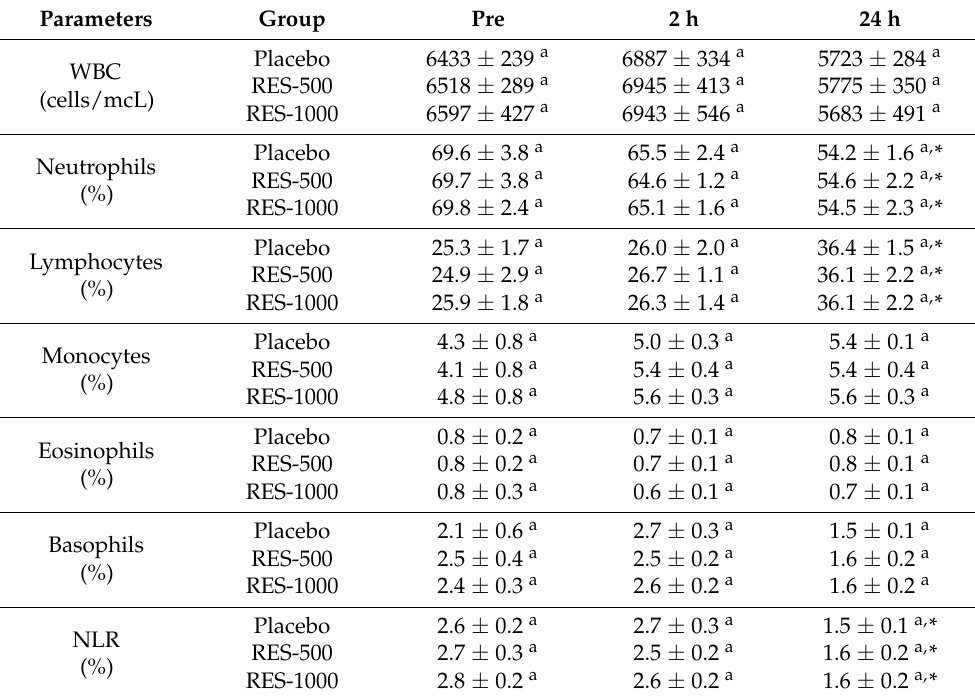
Table 1. The effect of RES supplementation on the blood count profiles of subjects.